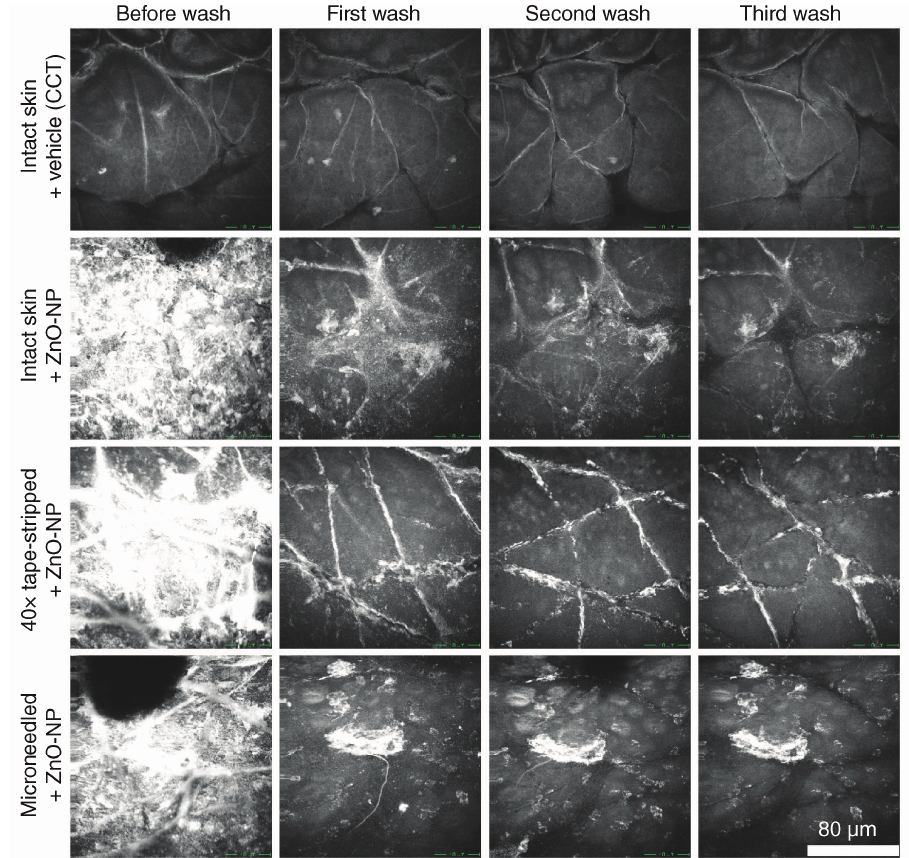
Figure 4. Multiphoton tomography of human skin applied with ZnO-NP. The rows are representative z -projection of the epidermal layers to superficial dermal-epidermal junction before wash, and after subsequent washes. CCT: Capric-caprylic triglyceride buffer. Reproduced with permission from [25], published by Future Medicine Ltd.,